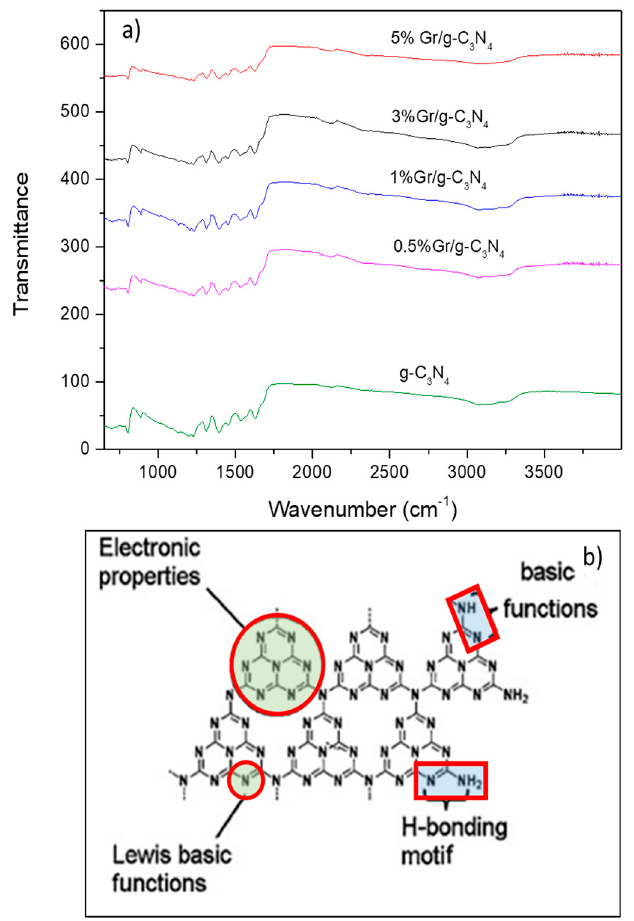
Figure 7. ( a ) FTIR spectrum of the g-C 3 N 4 samples; ( b ) the functional groups on g-C 3 N 4